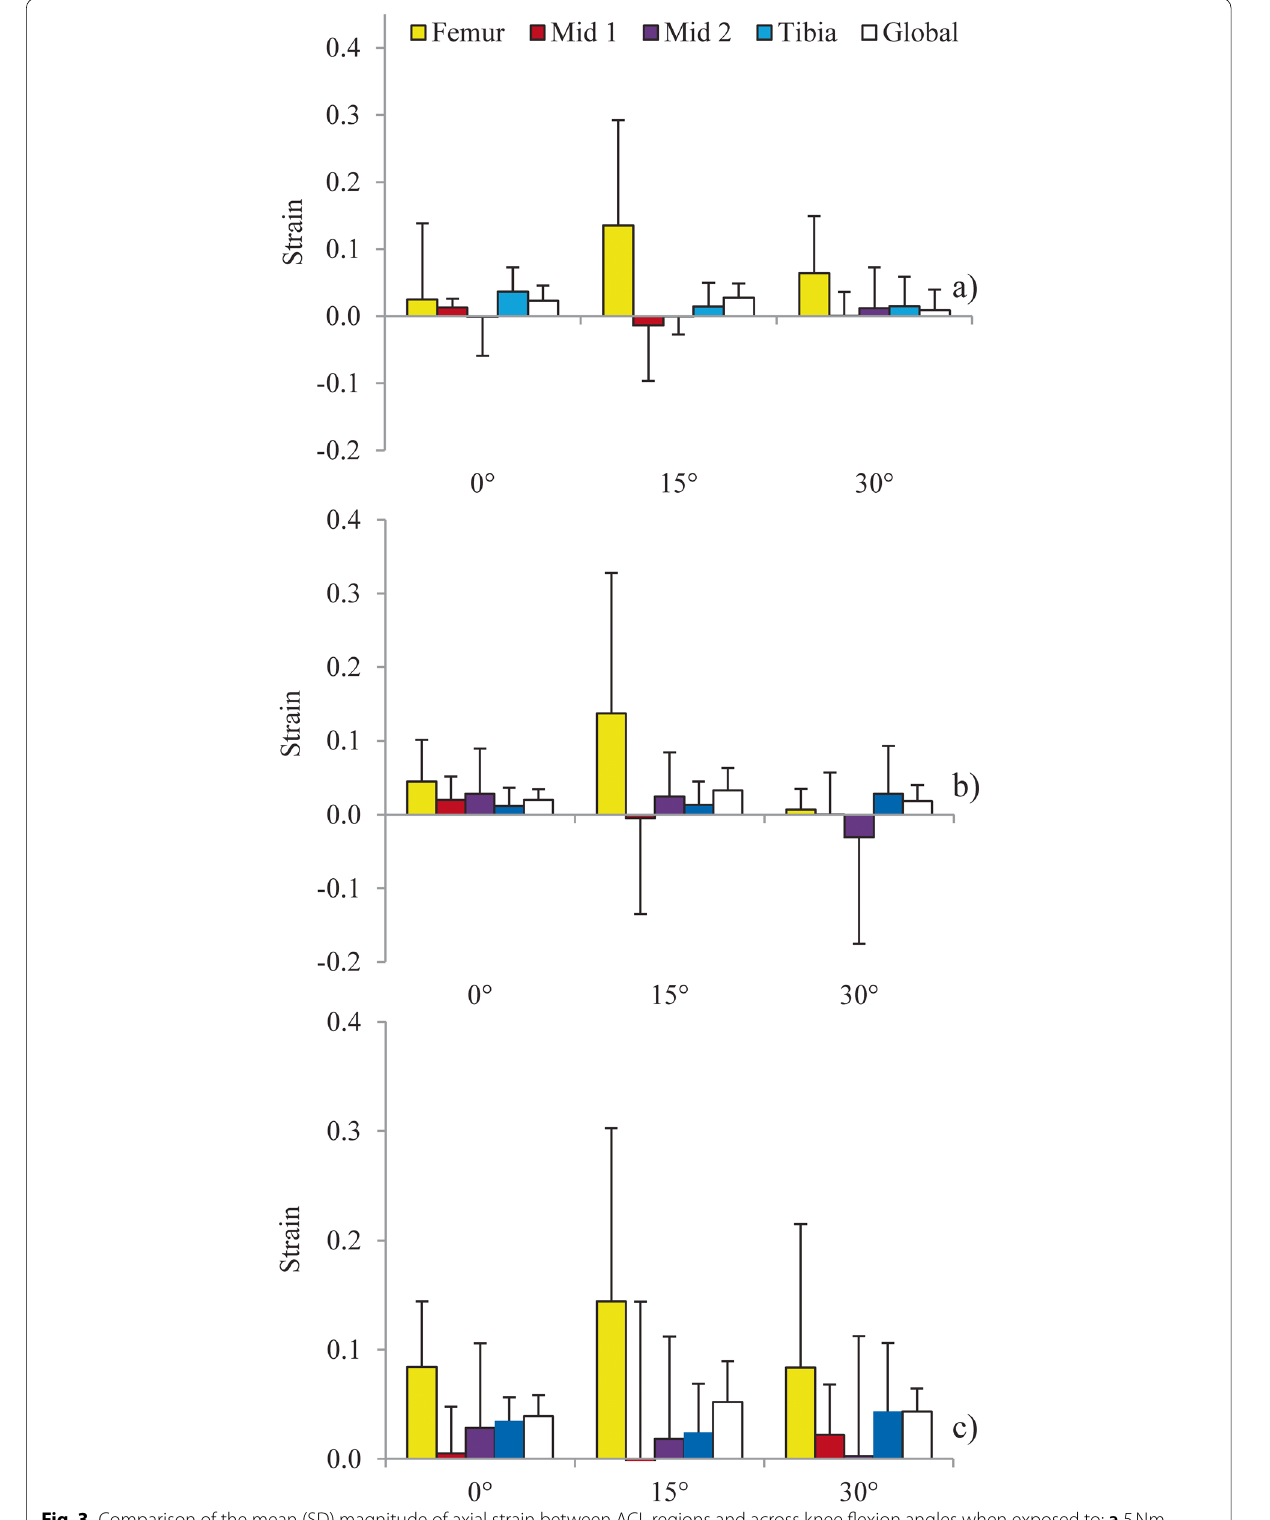
Fig. 3 Comparison of the mean (SD) magnitude of axial strain between ACL regions and across knee flexion angles when exposed to: a 5 Nm internal rotation; b 100 N anterior translation; and c simulated pivot